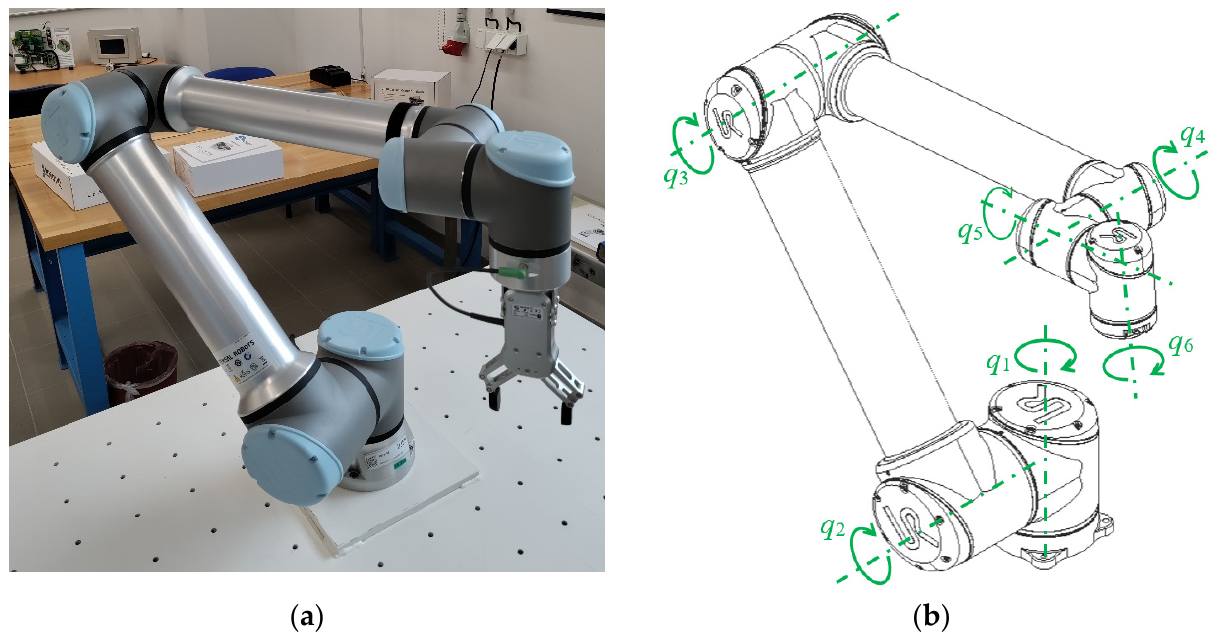
Figure 1. Six -axis collaborative robotic arm UR10: ( a ) photo of the robotic arm; ( b ) scheme of a robotic arm with marked joint axes.